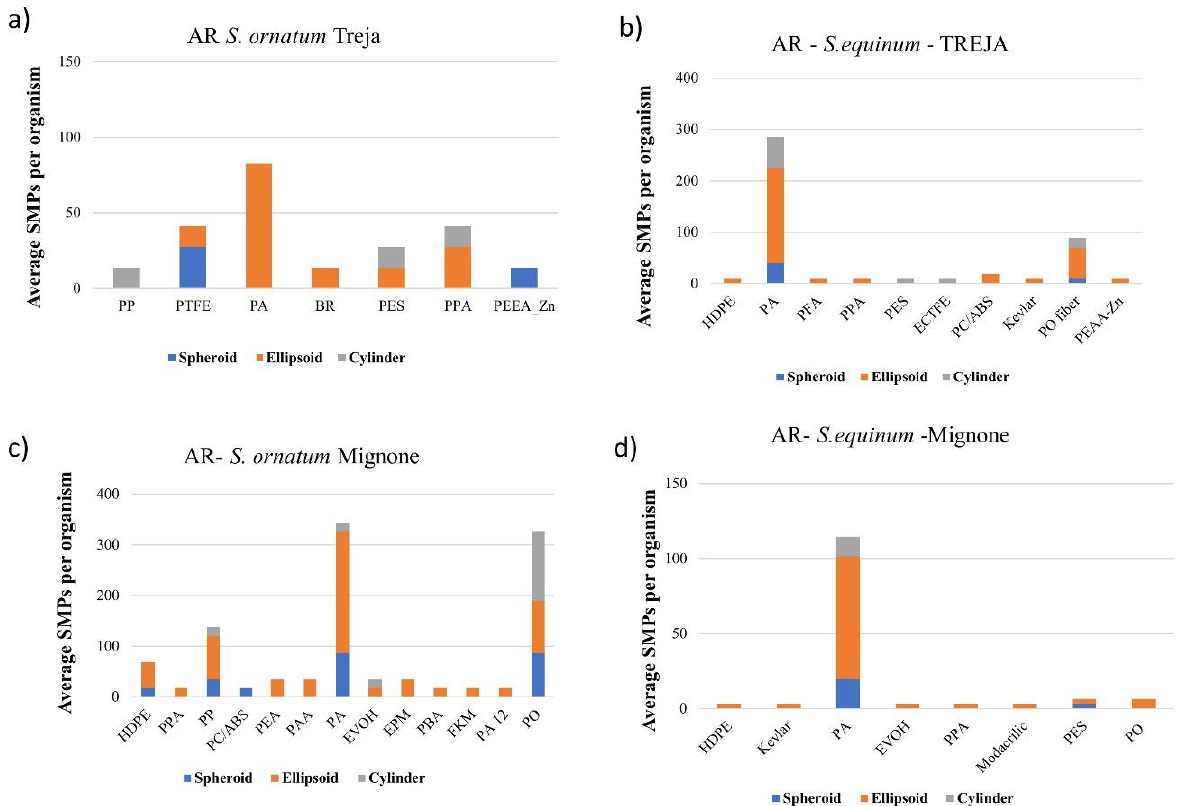
Figure 4. Aspect ratio (AR) of the polymers identified and quantified in specimens of S. ornatum ( a , c ) and S. equinum ( b , d ) under examination. The number of the spheroid, ellipsoid, and cylinder particle shapes is reported for the average abundance of each polymer identified and quantified via microscopic